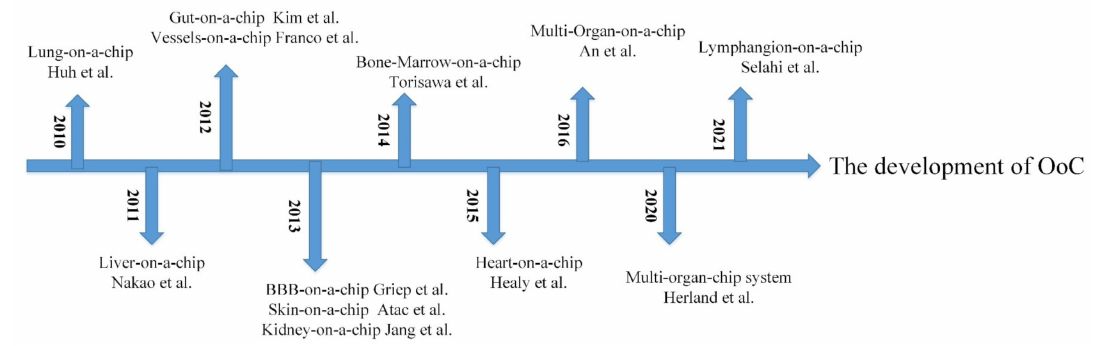
Figure 1. The development of